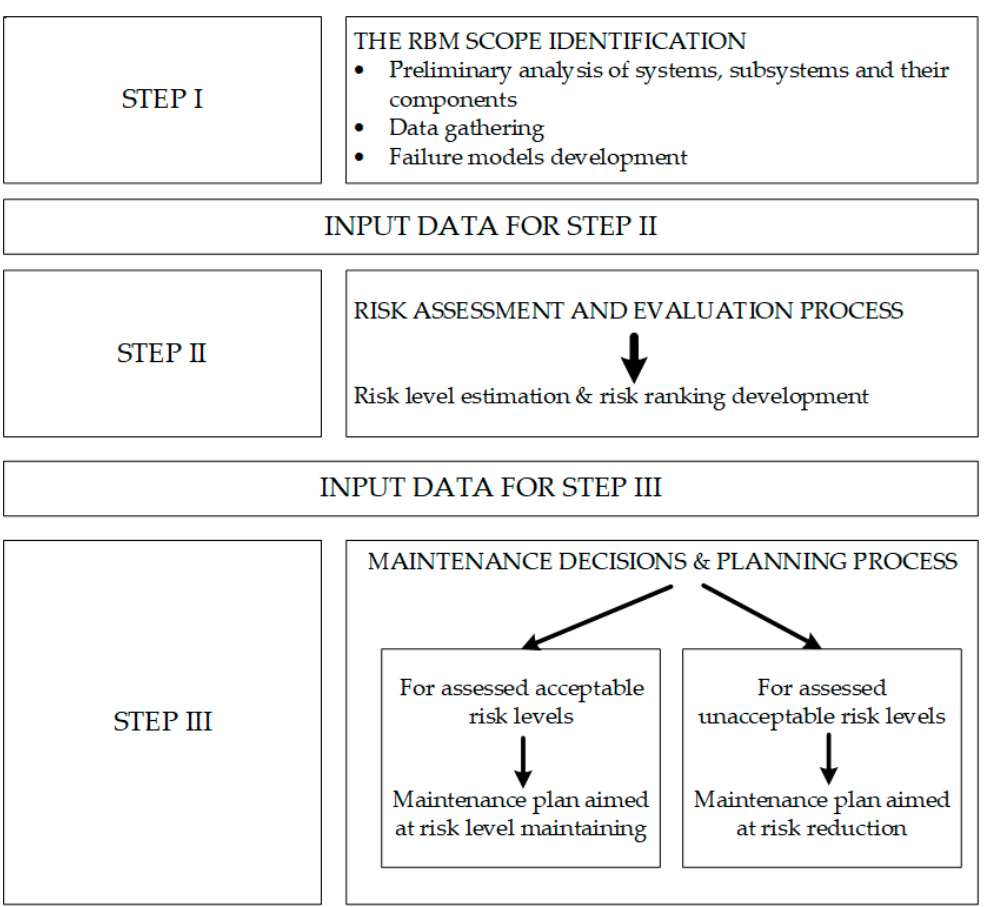
Figure 2. The architecture of RBM strategy. Source: own contribution based on [17].